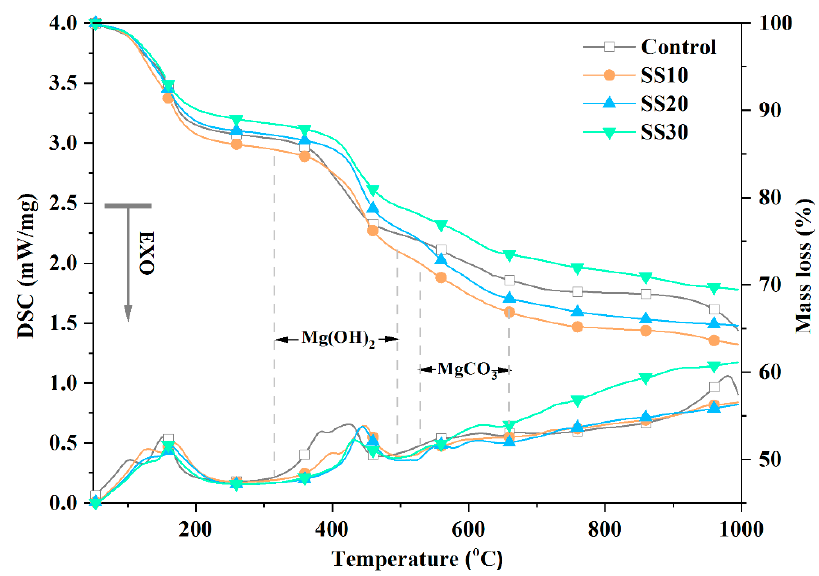
Figure 10. Thermogravimetric analysis–differential scanning calorimetry (TG–DSC) analysis of the decomposition temperatures of the control, SS10, SS20, and SS30 with CO 2 treatment after 28 day s curing.